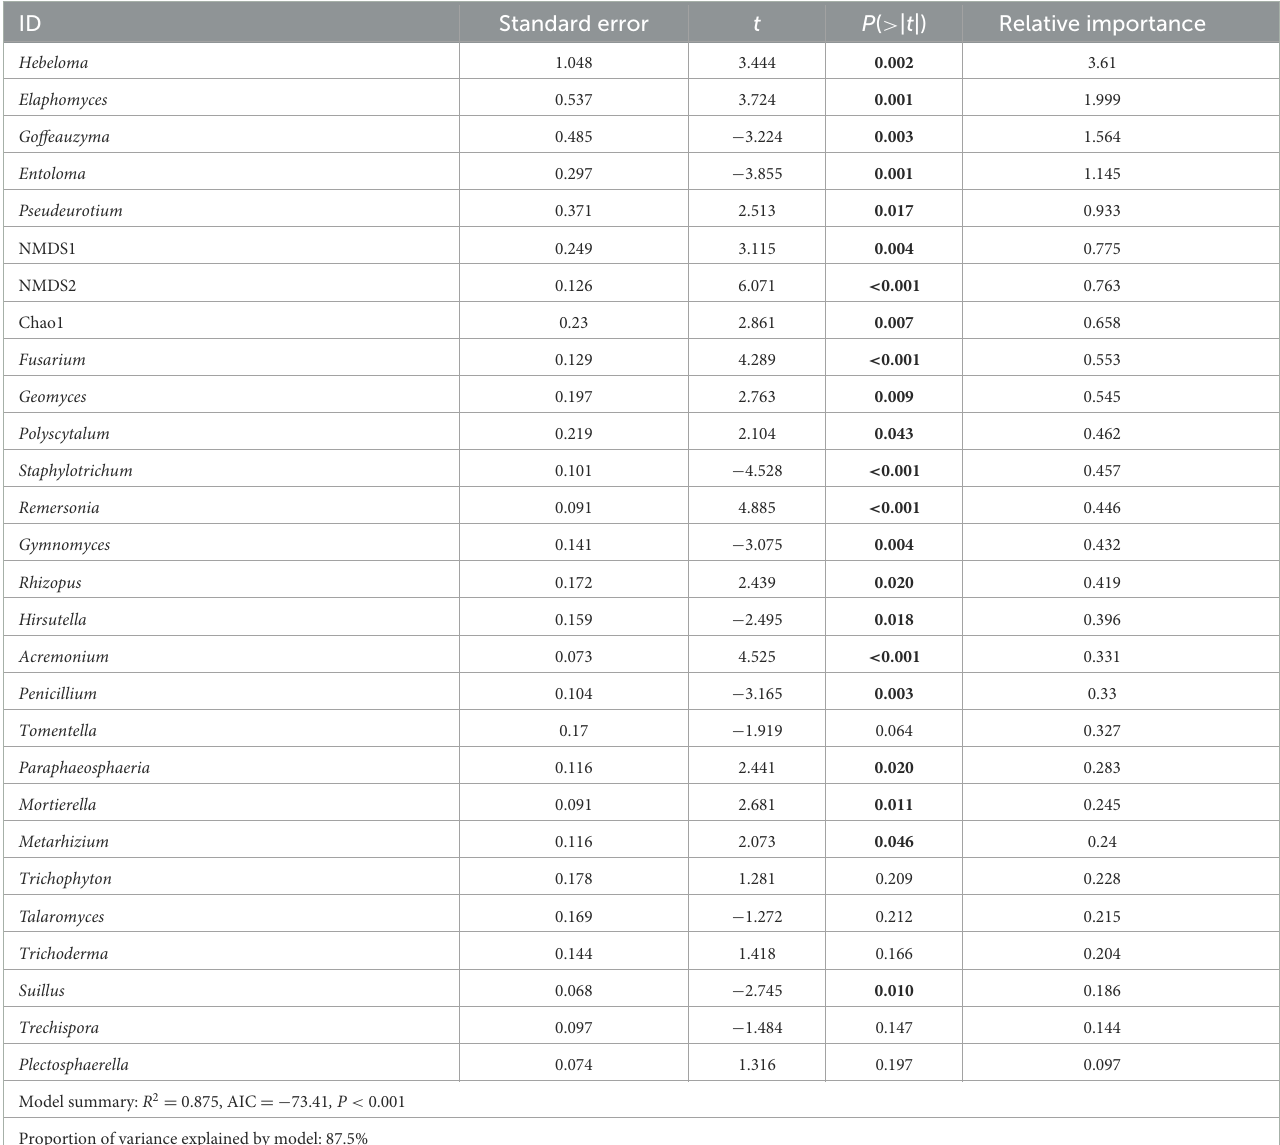
TABLE 2 Linear models (LM) for the relationship of fungal indicators with American ginseng root rot disease and the relative importance of each of the predictors in the model.